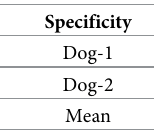
Table 4. Specificity by the two dogs.